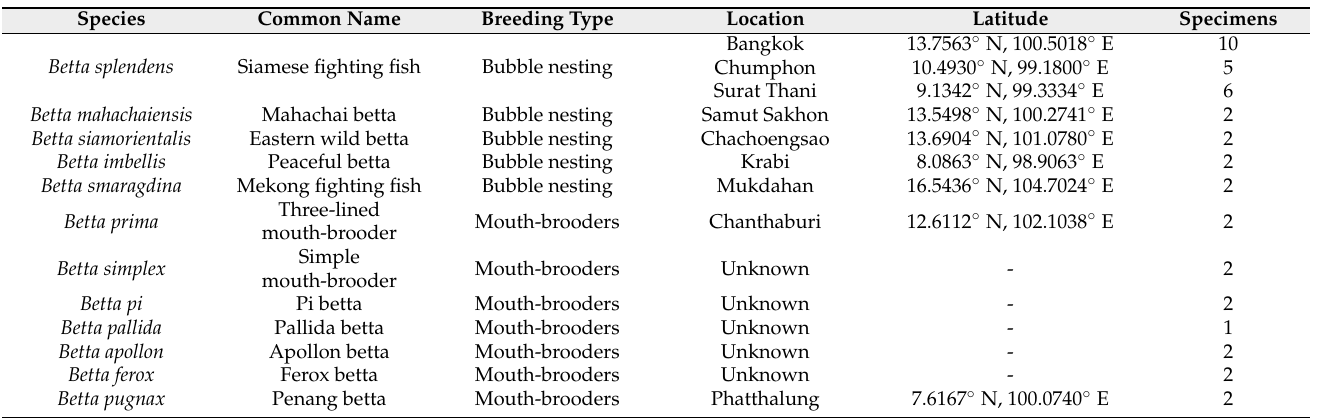
Table 1. Details of fighting fish used for microsatellite marker